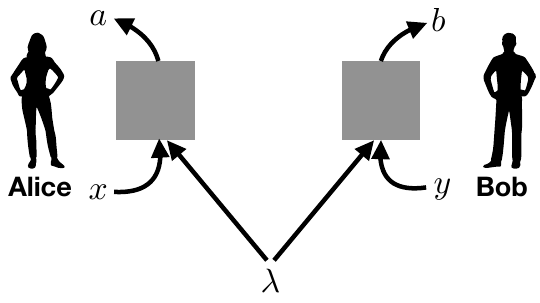
Figure 2: Schematic figure of a Bell scenario. Within any physical theory (classical physics, quantum physics, or other), we can imagine laboratory situations in which the causal structure is specifically as depicted (in particular, Alice and Bob cannot communicate). Regardless of the interpretation of “probability”, we can talk about situations in which there is data to be chosen independently ( x and y ) and recorded ( a and b ) such that it is meaningful to talk about the probabilities of the recordings, given the choices. Data from the past that may influence the devices will be labelled λ . Physical theories differ in the set of probability tables (“correlations”) that they allow in principle in this